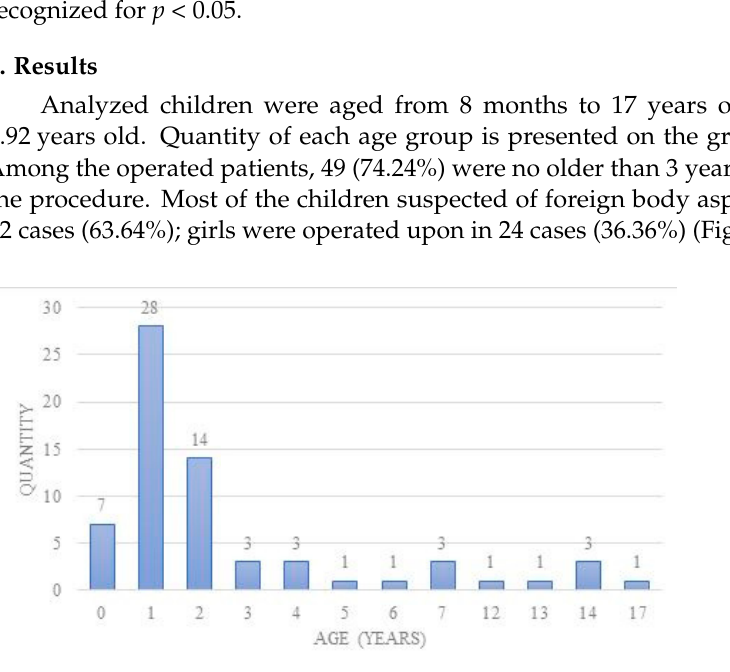
Figure 2. Sex of patients suspected of foreign body aspiration. Most raised complaints included choking (54 cases; 81.81%), swallowing foreign ob- ject (6 cases; 9.09%), cough (3 cases; 4.55%), dyspnea (2 cases; 3.03%), and dyspepsia (1 case; 1.52%). In the analyzed group, X-ray imaging results included: evidence of foreign body (metal objects), unilateral pneumothorax or atelectasis, intensified vascular pattern, em- physema, and mediastinum dislocation (Figure 3). ( a )